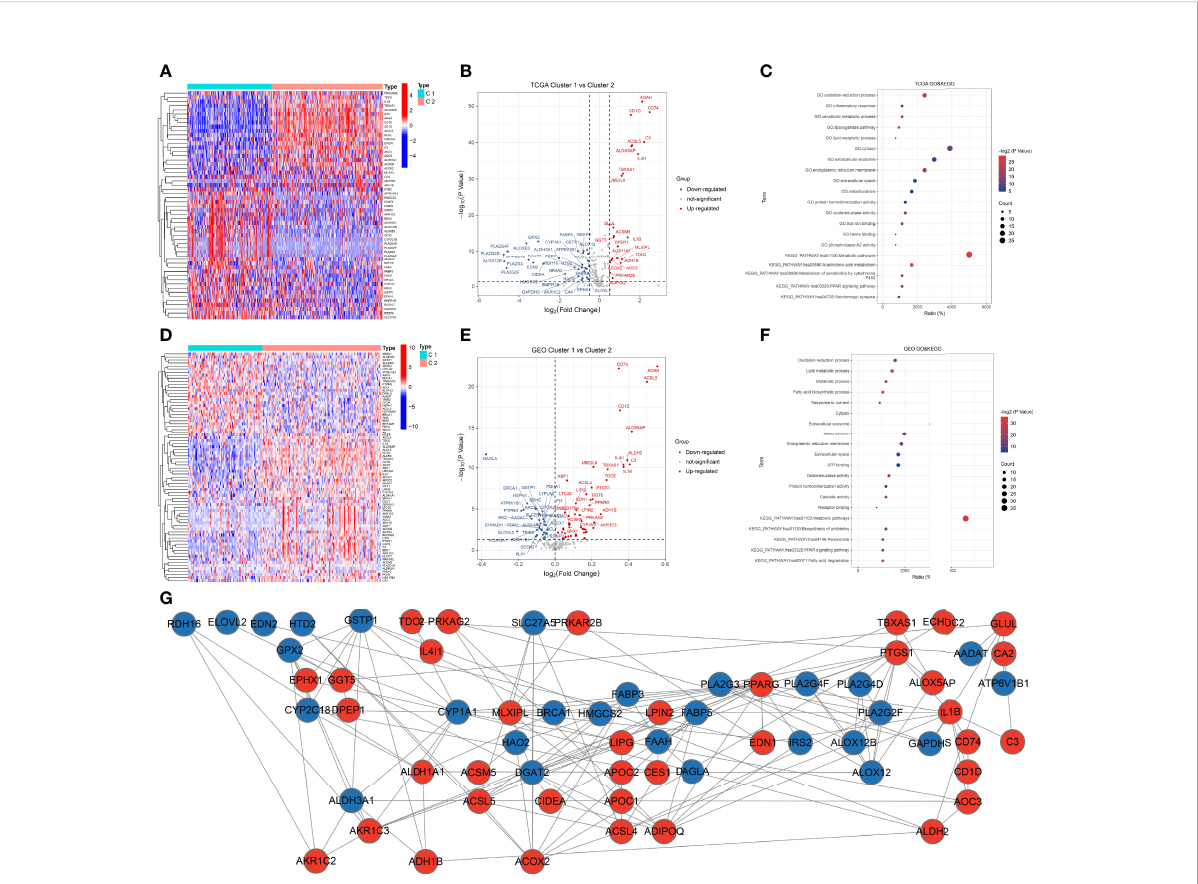
FIGURE 4 DEFAMGs between FAM molecular subtypes. (A, B) Heatmap and volcano plot of DEFAMGs between cluster 1 and cluster 2 in the TCGA cohort. (C) GO and KEGG enrichment analyses of DEFAMGs in the TCGA cohort. (D, E) Heatmap and volcano plot of DEFAMGs between cluster 1 and cluster 2 in the GEO cohort. (F) GO and KEGG enrichment analyses of DEFAMGs in GEO cohort. (G) The PPI network that includes an intersection of TCGA and GEO